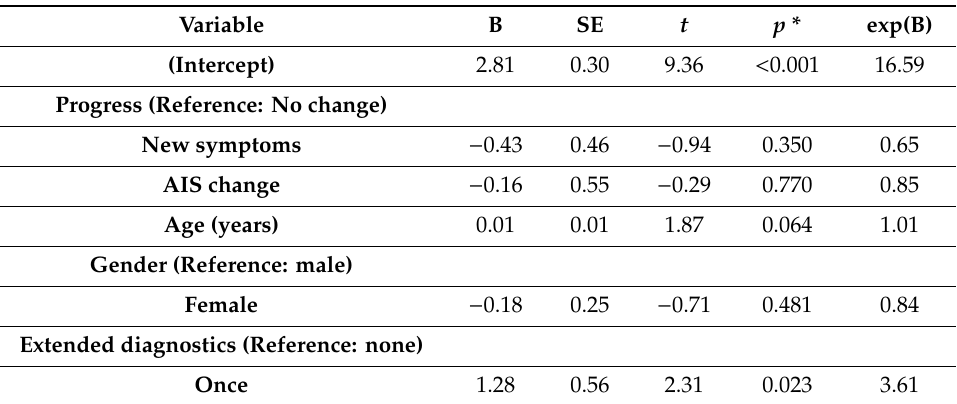
Table 10. Regression analysis results for length of stay.